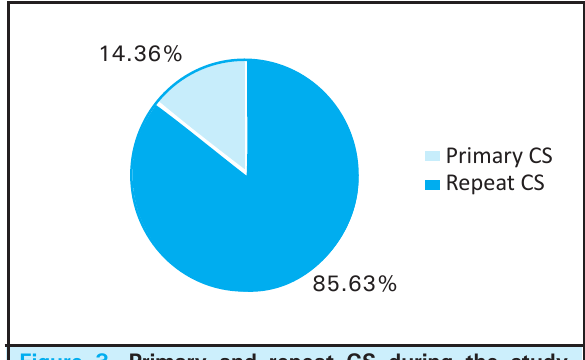
Figure 3. Primary and repeat CS during the study